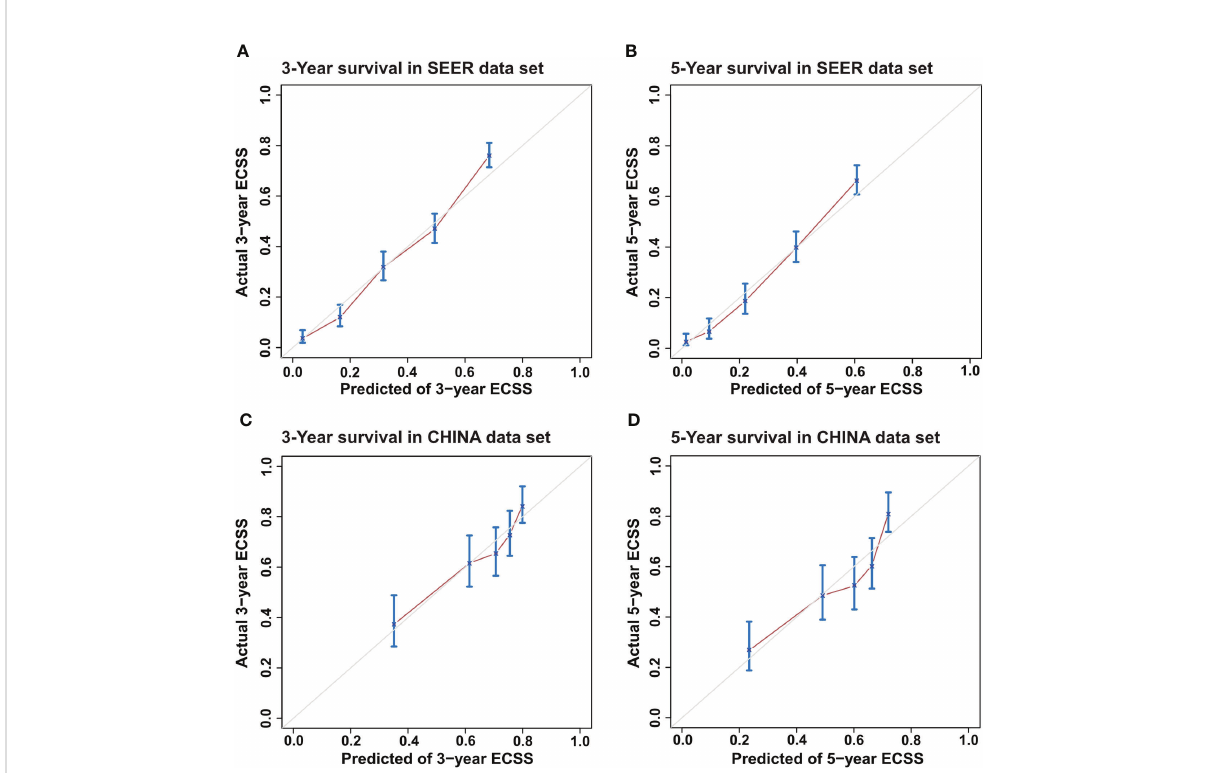
FIGURE 3 Calibration plots for Esophageal Cancer-Speci fi c Survival (ECSS) for the DeepSurv model. (A) 3-year and (B) 5-year ECSS of Surveillance, Epidemiology, and End Results (SEER) dataset and (C) 3-year and (D) 5-year ECSS of CHINA